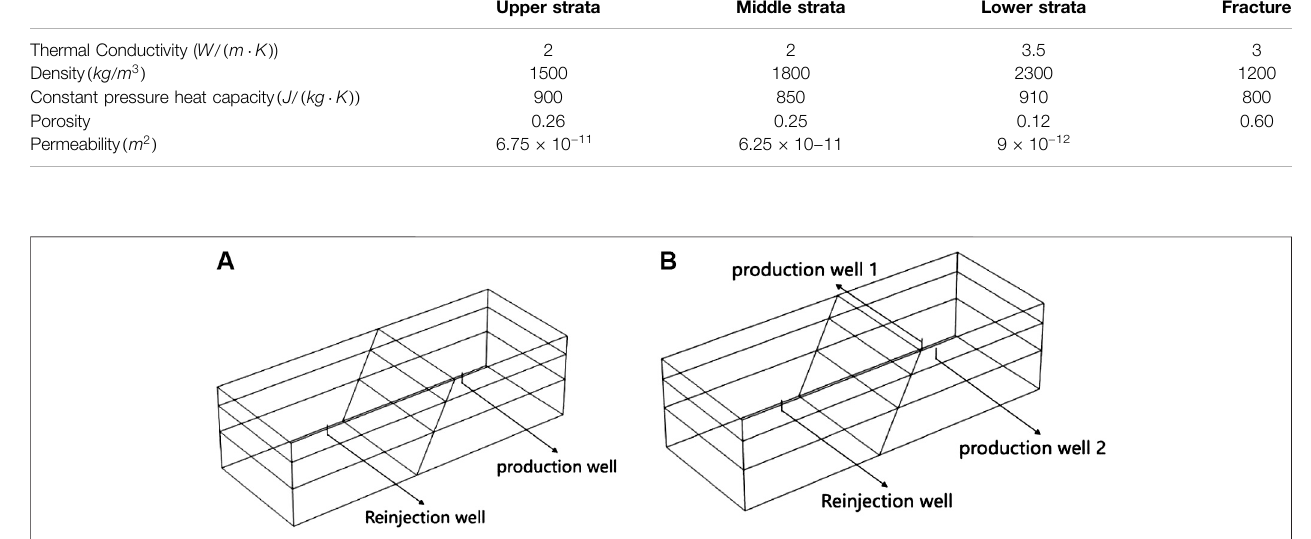
TABLE 2 | Geological parameters. Thermal Conductivity ( W / ( m · K ) )